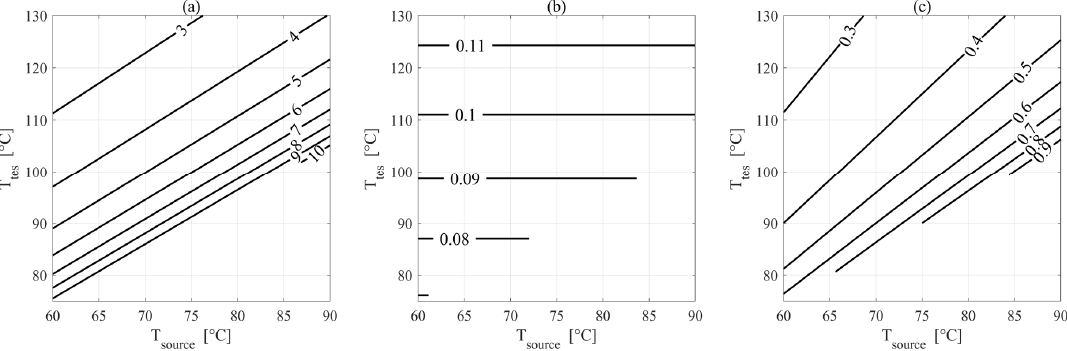
Figure 9. “Hot TI-PTES” performance parameters in terms of heat source temperature T source and TES temperature T tes . ( a ) VCHP COP ; ( b ) ORC η ; ( c ) TI-PTES ε rt .